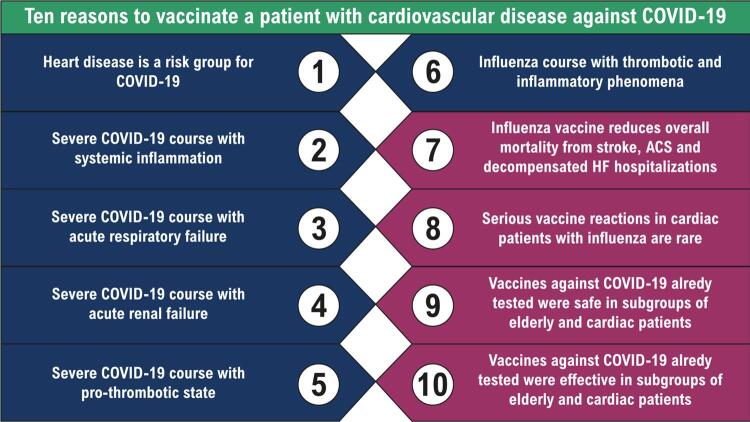
– Ten reasons to vaccinate a patient with cardiovascular disease against COVID-19. ACS: acute coronary syndrome; HF: heart failure. Source: The authors.